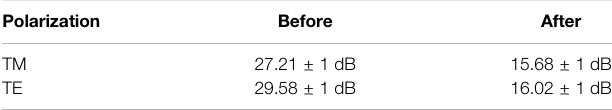
TABLE 2 | Measured insertion losses at 633 nm prior and after 24 h annealing in air for TE and TM polarized incident light. Polarization